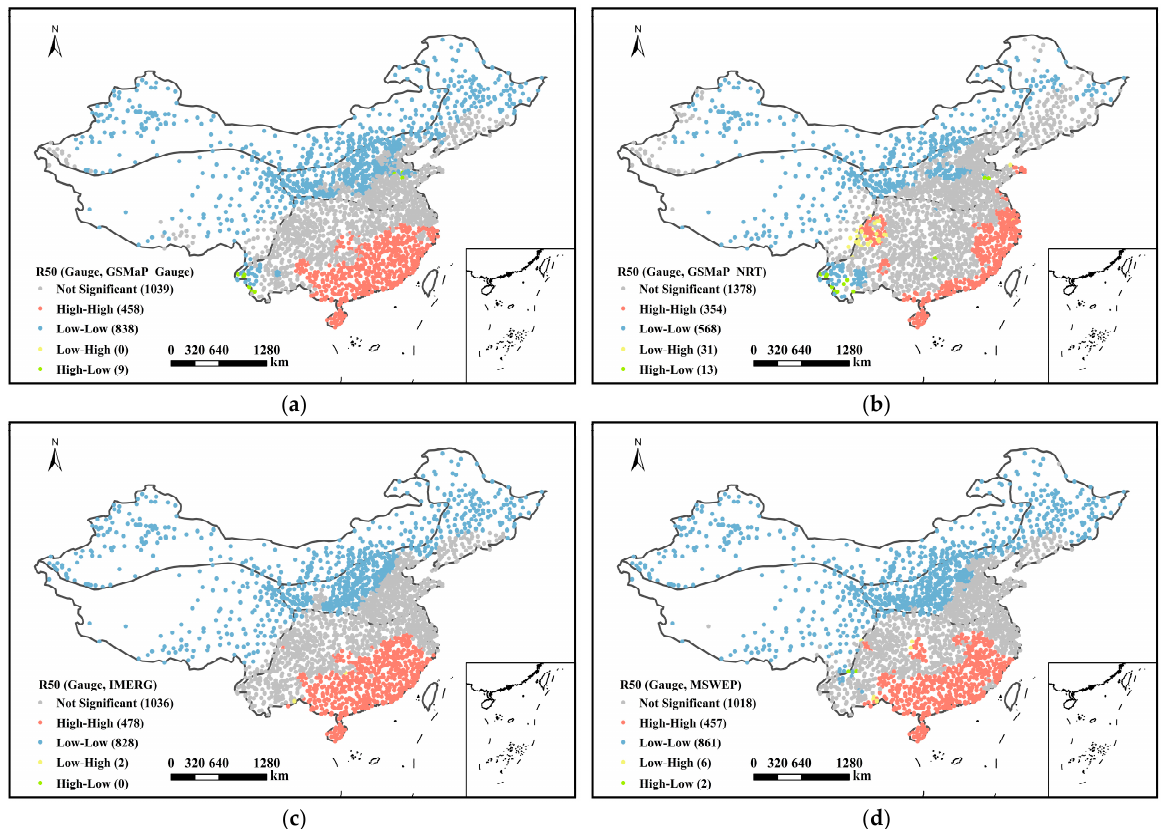
Figure 17. The LISA cluster maps of R50 between the gauge observations and the four SPPs and the number in the bracket represent the corresponding number of gauges: ( a ) GSMaP_Gauge, ( b ) GSMaP_NRT, ( c ) IMERG, and ( d ) MSWEP. BMI in Four Sub-Regions